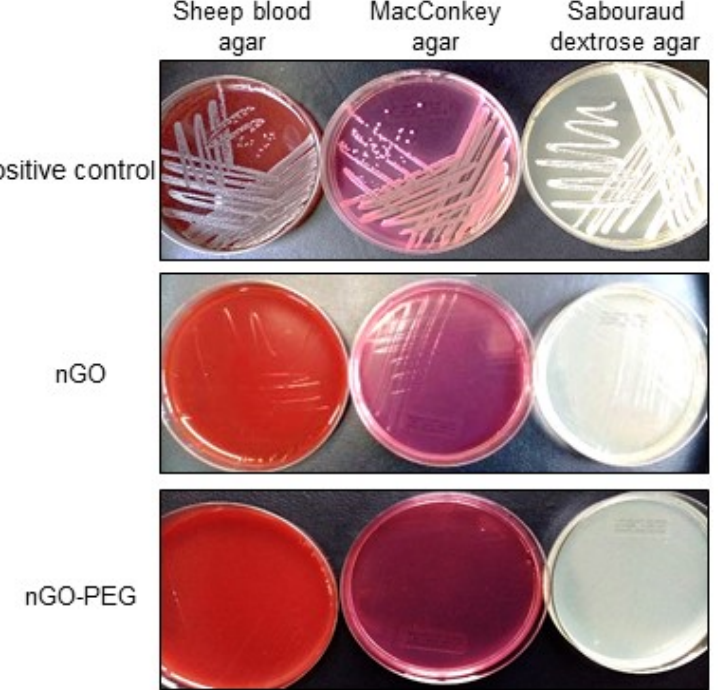
Figure 4. Microbial and fungal sterility of nGO and nGO-PEG nanoparticles suspensions. Pristine GO and nGO-PEG nanosheets were streaked on three different types of agar plates: Columbia agar with 5% Sheep Blood (Becton Dickinson) for Gram (+) and Gram (–) microorganisms; MacConkey agar (Becton Dickinson)—a selective and differentiating agar for Gram (–) bacterial species, and Sabouraud Dextrose Agar (Becton Dickinson)—a nonselective medium for fungi, particularly Staphylococcus aureus, Escherichia coli and Candida albicans were used as positive controls of bacterial and fungal growth. Agar plates were incubated for 72 h at 37°C. Microphotographs were taken with a Nikon D700 reflex camera (Nikon, Tokyo, Japan).